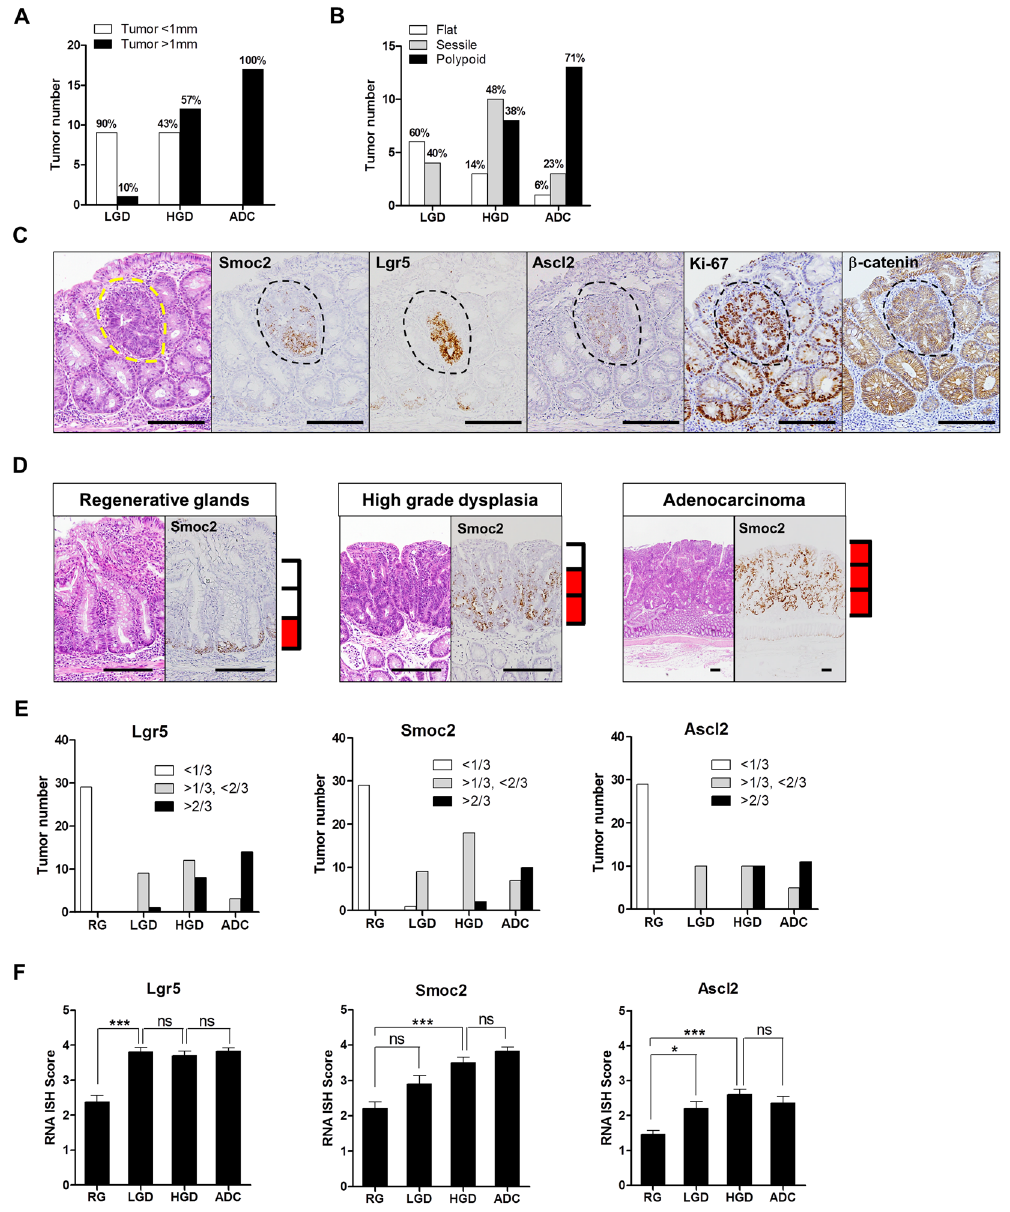
Figure 4. Distribution and intensity of crypt base columnar (CBC) stem cell markers in colitis-associated dysplastic lesions and cancers. ( A ) The number of tumors according to size and histologic grades. ( B ) The number of tumors according to gross appearance and grades. ( C ) RNA in situ hybridization (ISH) for Smoc2, Lgr5, and Ascl2 in an aberrant crypt focus indicated by a yellow or black dotted lines. Scale bar: 100 μ m. ( D ) Representative images of Smoc2 expression with three distribution patterns in RG, HGD, and ADC cases. Red box indicates the area of Smoc2-expressing cells in the crypt or tumor height. ( E ) Distribution of CBC stem cell markers in all RG (n = 29), LGD (n = 10), HGD (n = 20), and ADC (n = 17) cases. < 1/3: lower than one- third of the crypt or tumor height; > 1/3, < 2/3: higher than one-third, but lower than two-thirds of the crypt or tumor height; > 2/3: higher than two-thirds of the crypt or tumor height. ( F ) RNA ISH intensity of CBC stem cell marker expression. Data represent the means ± SEM. (RG: regenerative glands, LGD: low grade dysplasia, n = 10; HGD: high grade dysplasia; ADC, adenocarcinoma; ns, not significant; SEM, standard error of the mean. * P < 0.05; *** P <